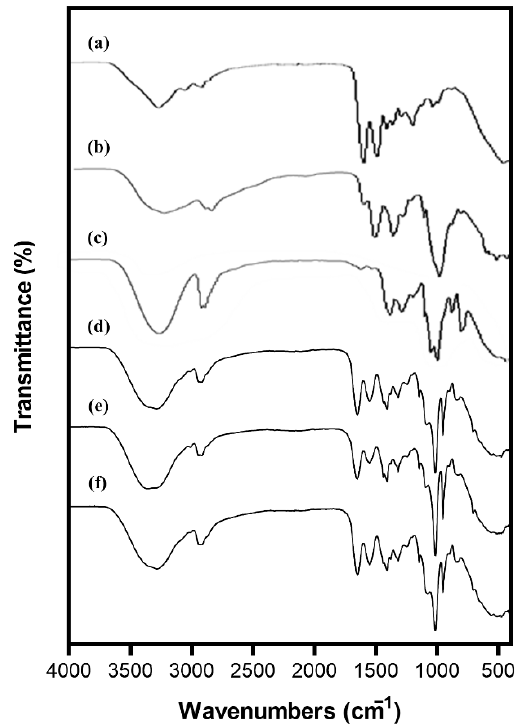
Figure 2. FTIR spectra of chitosan ( a ), gelatin ( b ), poly(vinyl alcohol) ( c ), CGP ( d ), CGPD1 ( e ), and CGPD2 ( f ).